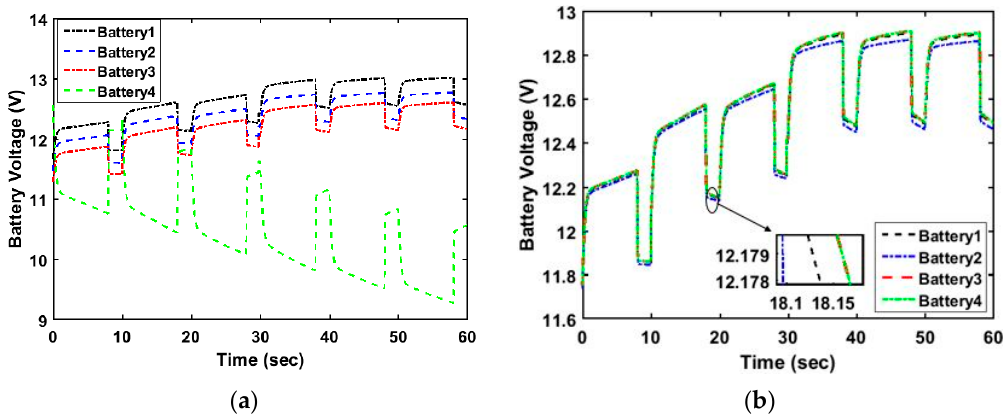
Figure 17. Individual battery Voltages ( a ) without and ( b ) with the proposed method.